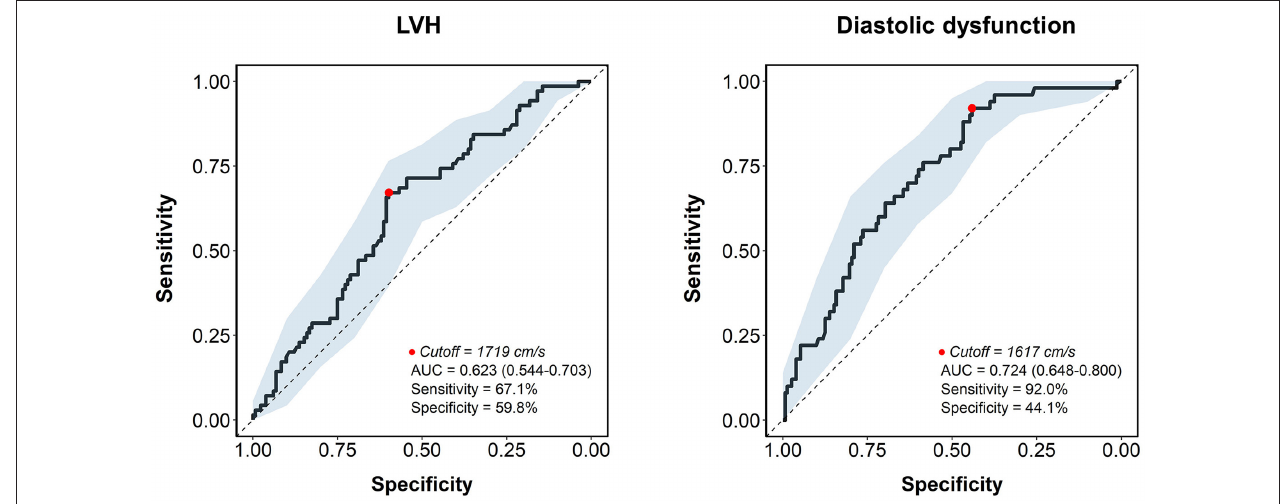
FIGURE 3 | The receiver operating characteristic curve analysis of baPWV for predicting LV hypertrophy and diastolic dysfunction. The receiver operating characteristic curve is depicted as a solid line with 95% confidence interval (shaded area). The cutoff point is marked with a red dot. AUC, area under the curve; baPWV, brachial-ankle pulse wave velocity; LVH, left ventricular